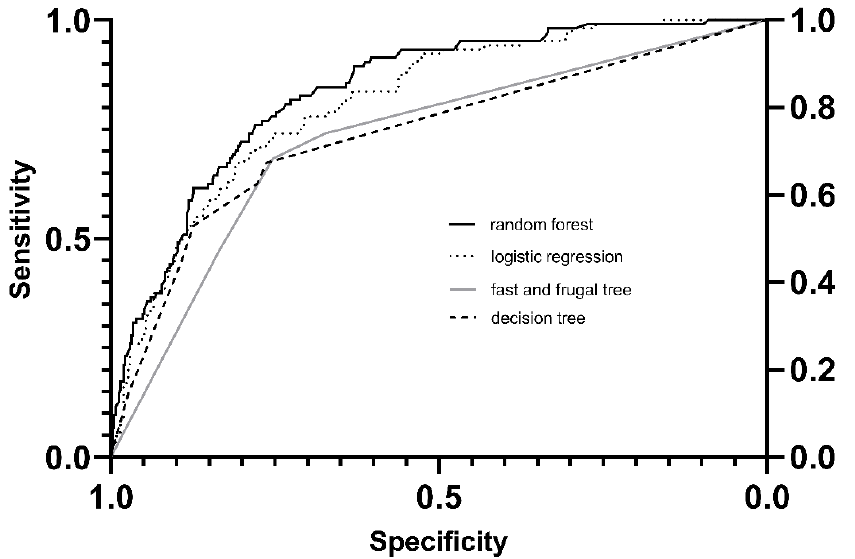
Figure 4. Comparison of Models.